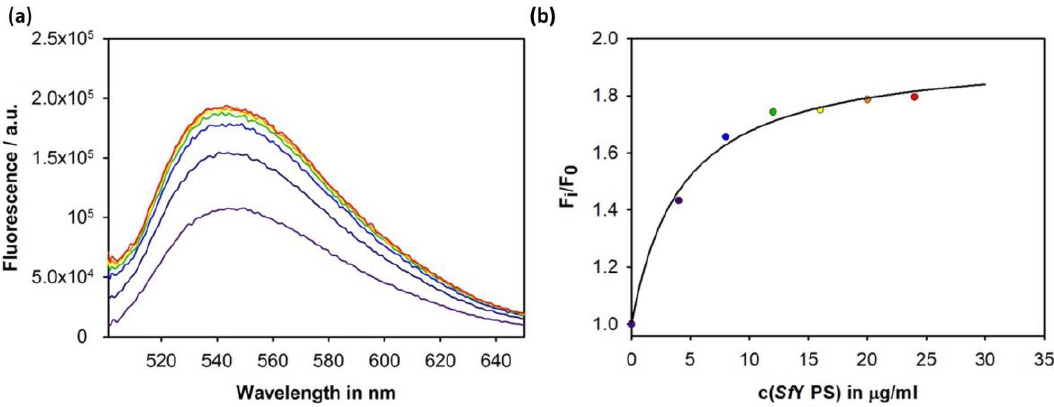
Figure 4. ( a ) Fluorescence emission spectra at 10 °C of Sf6TSP (184 nM) covalently linked to a N -methyl- N -[2-[methyl(7-nitro-2,1,3-benzoxadiazol-4-yl)amino]ethyl] (NBD) dye label in the absence (purple) or presence of increasing amounts of S. flexneri serotype Y polysaccharide preparations at λ ex = 492 nm (Polysaccharide concentrations in µg mL −1 : purple = 0; dark blue = 4; light blue = 8; green = 12; yellow = 16; orange = 20; and red = 24). ( b ) Binding isotherm of polysaccharide binding to Sf6TSP-NBD. Data was fitted to a single binding site model to obtain a polysaccharide half-saturation concentration of 4.1 µg mL −1 (Color of data points correspond to curves in ( a )).